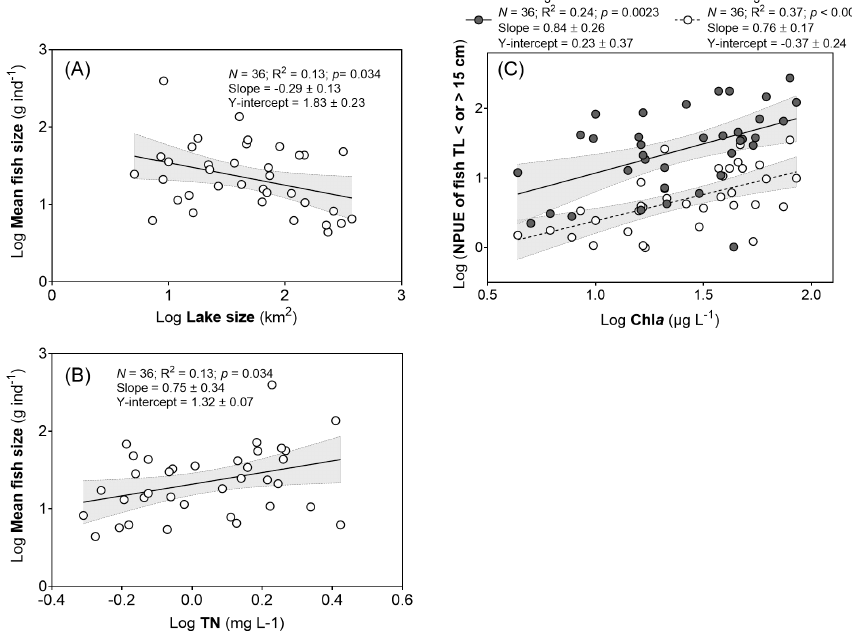
Figure 5. Relationships between mean body weight (total biomass/total numbers) of all fish caught ( A , B ) and when divided into two size classes based on fish total length (TL, ( C )) and environmental variables. NPUE, catch per unit effort in numbers; Chl a , chlorophyll- a concentration in phytoplankton; TN, total nitrogen concentration in the water. The dashed lines represent the 95% confidence band.